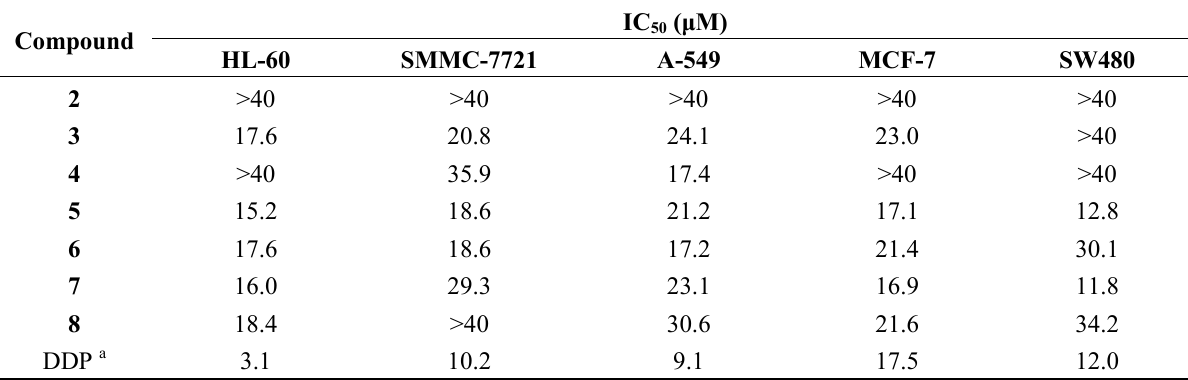
Table 3. Cytotoxicities of compounds 2 – 8 against five cancer cell